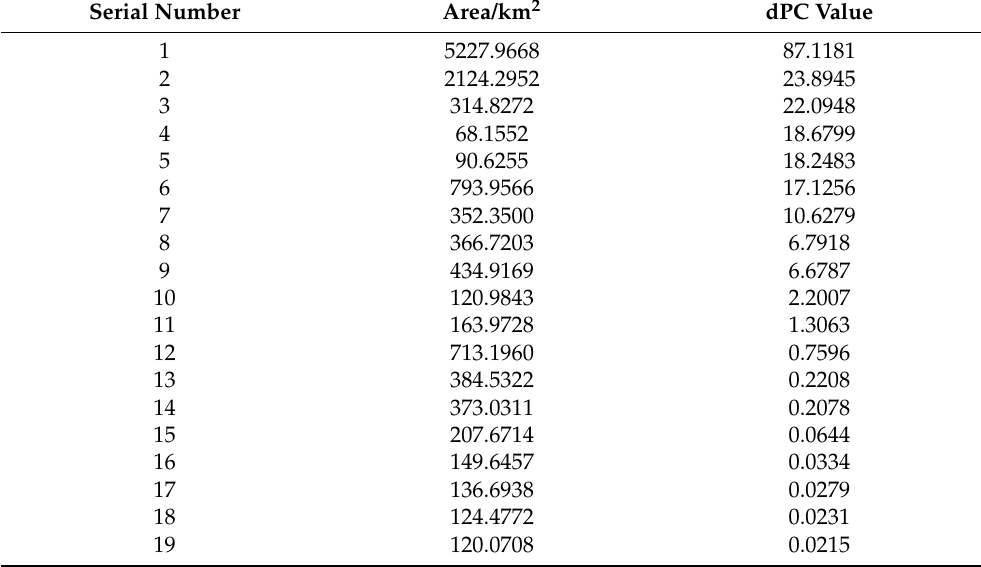
Table 3. Importance of heat source dPC value.